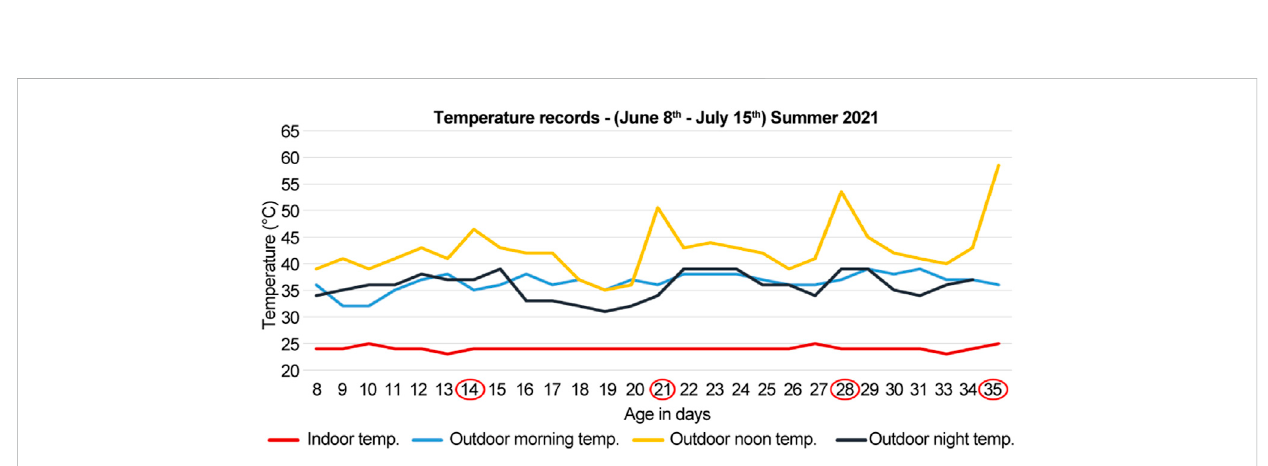
FIGURE 2 Temperaturerecordsforthesummerof2021(monthsofJuneandJuly).Thedocumentedtemperatureduringthemorning,noon,andnightforthe control(indoor)andheat-treated(outdoor)groups.The fi rst,second,third,andfourthgroupsweresacri fi cedat14-,21-,28-,and35-days(circledinred), respectively. The peaks indicate direct exposure to sun at noon for 10 min before sacri fi ce of the heat-treated